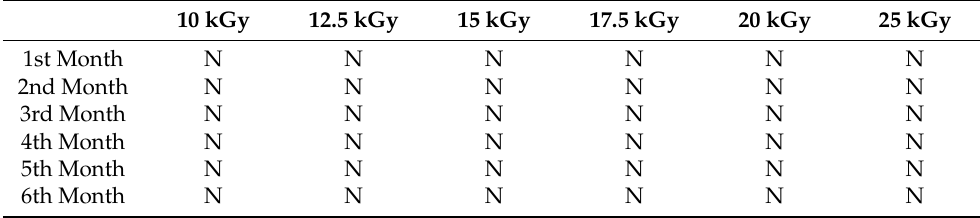
Table 1. The aerobic counts and yeast and mold count of 10% WPI solutions after